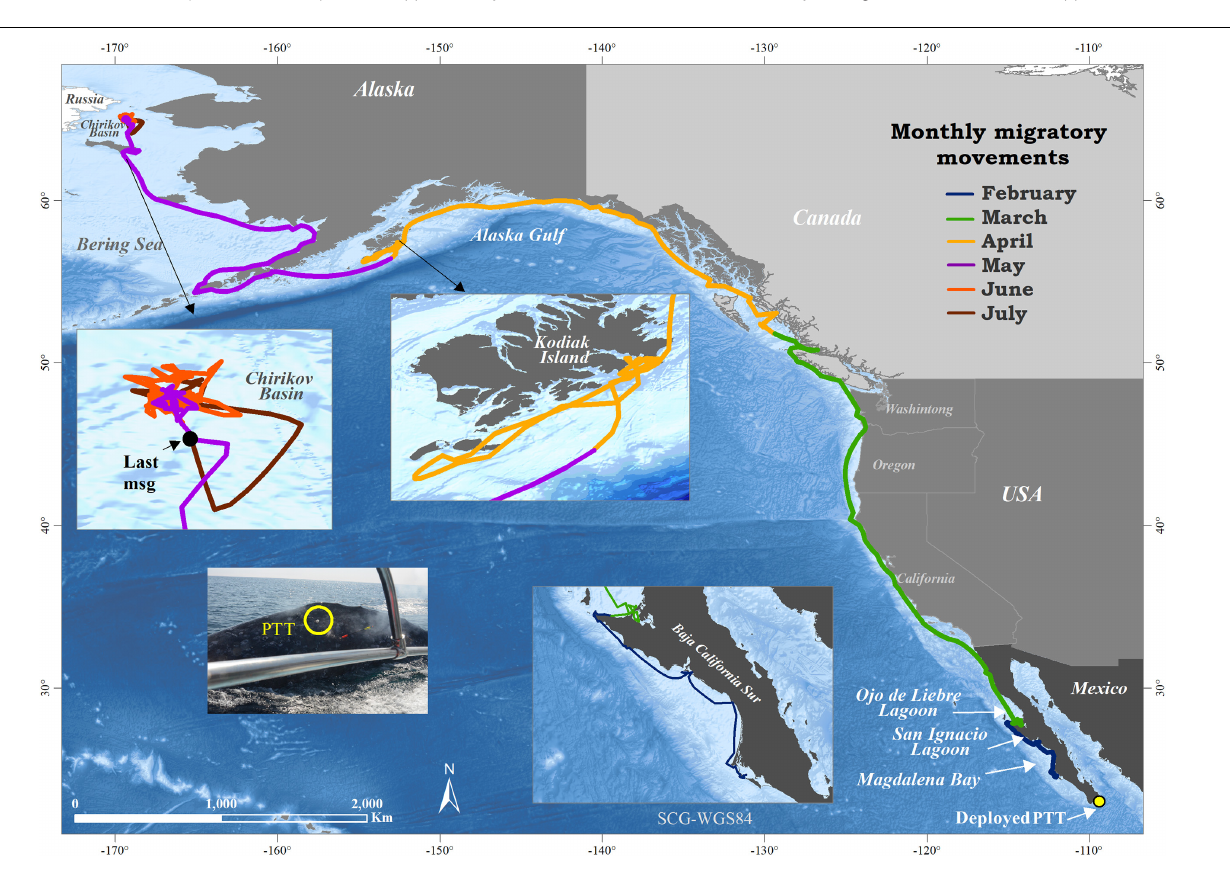
spatial analysis based on a spatial location called Global